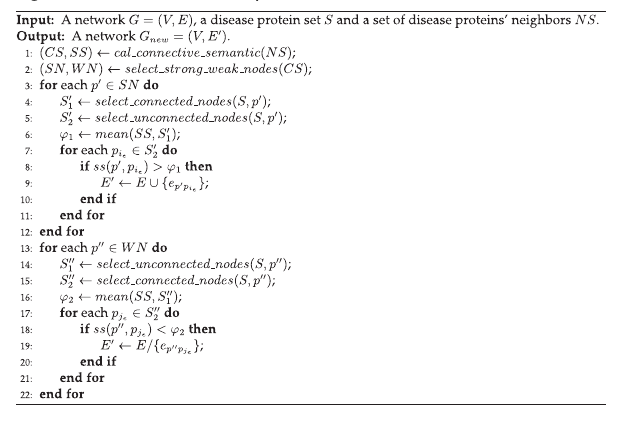
Algorithm 2. Network-adjustment ( G, S, NS